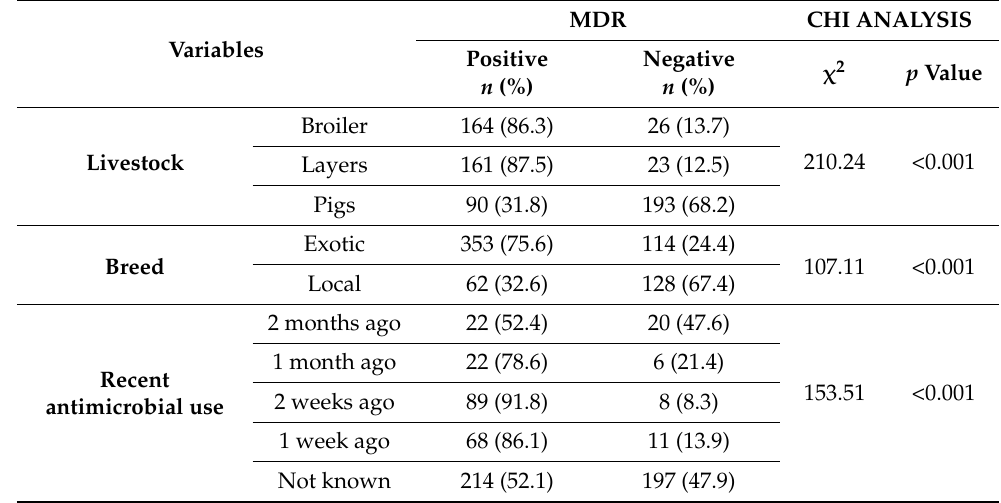
Table 6. Factors associated with MDR